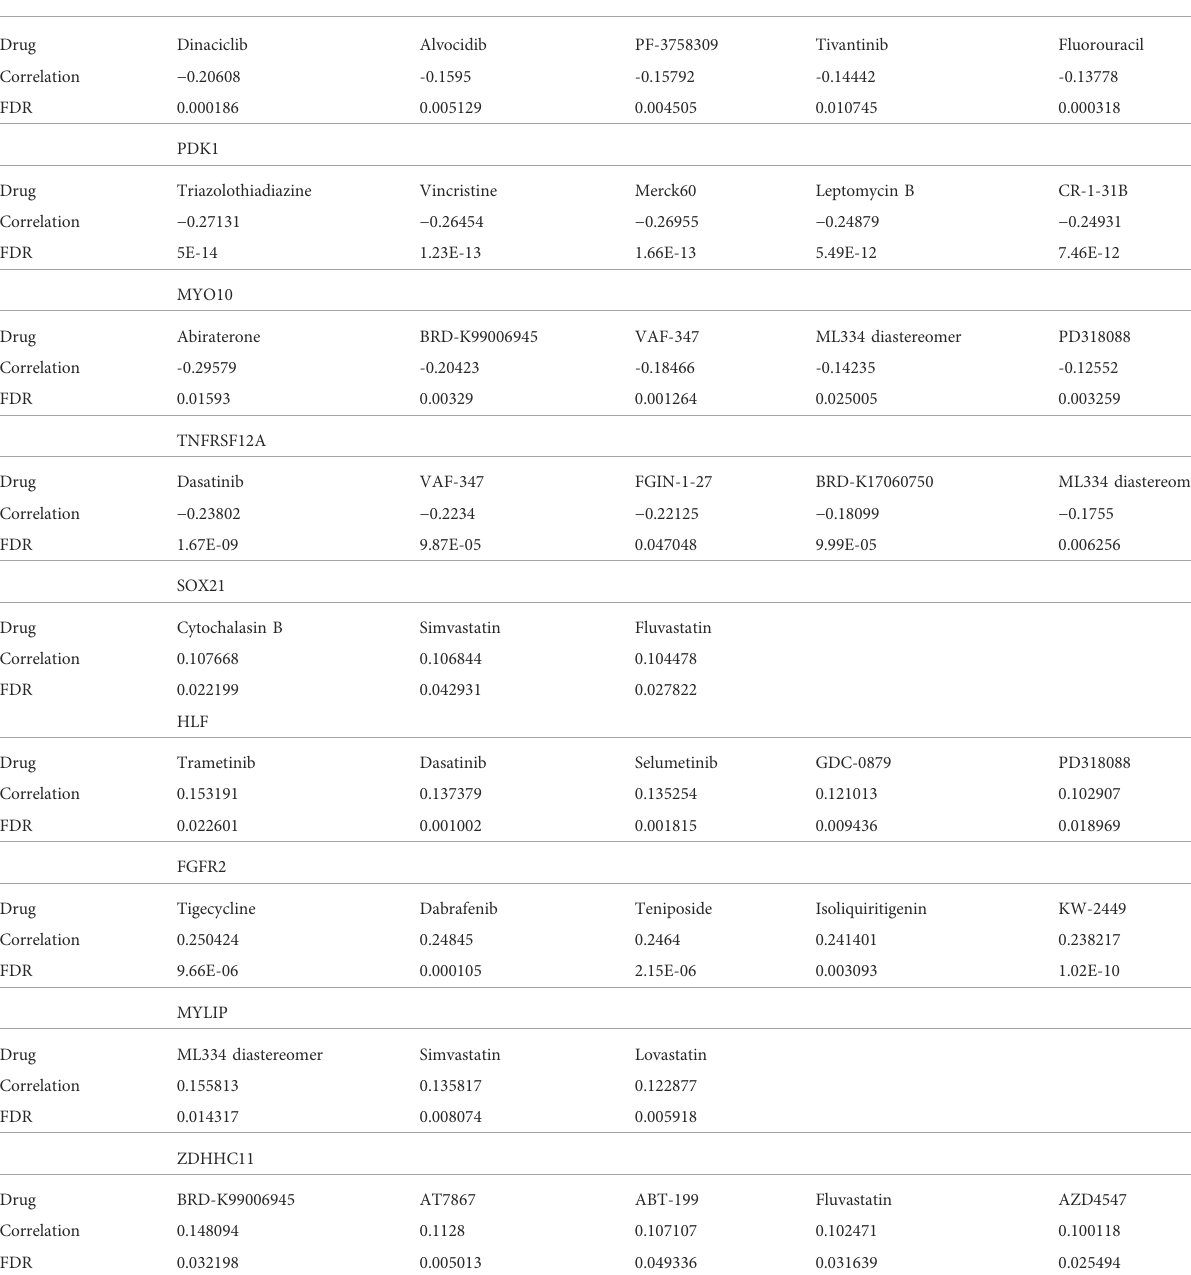
TABLE 2 Predicting potential chemo drugs via the Cancer Therapeutics Response Portal